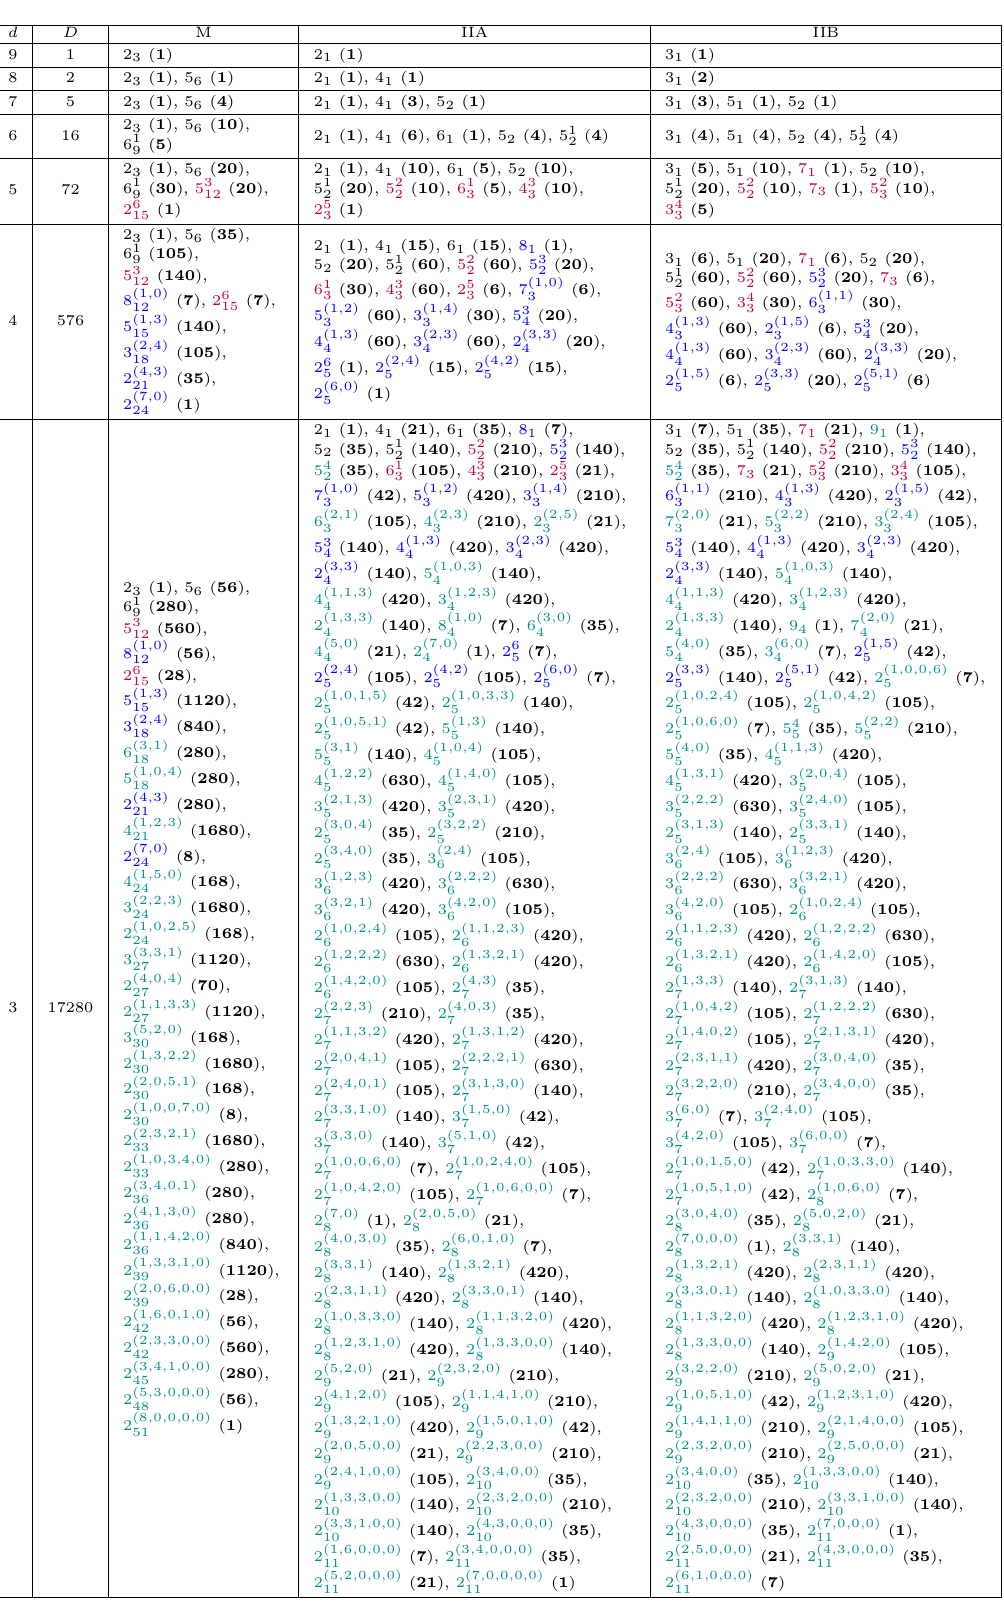
Table 9 . Branes in the membrane